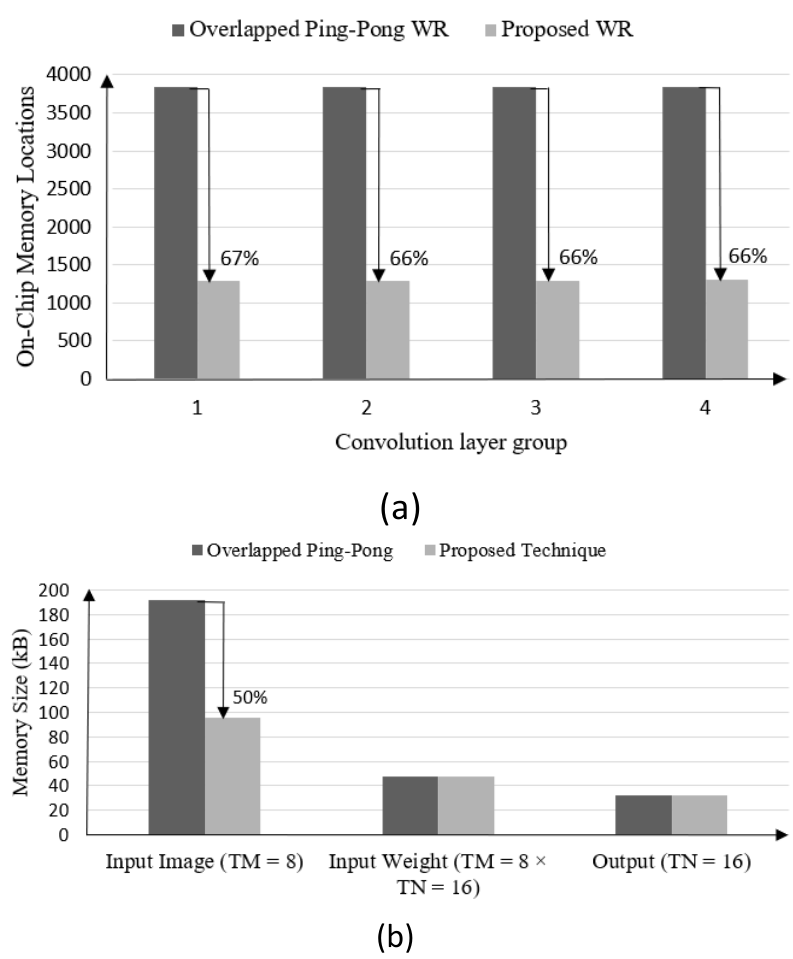
Figure 13. On-chip memory size comparison. ( a ) The results are for traditional ping-pong memory technique with proposed design. ( b ) The overall memory size